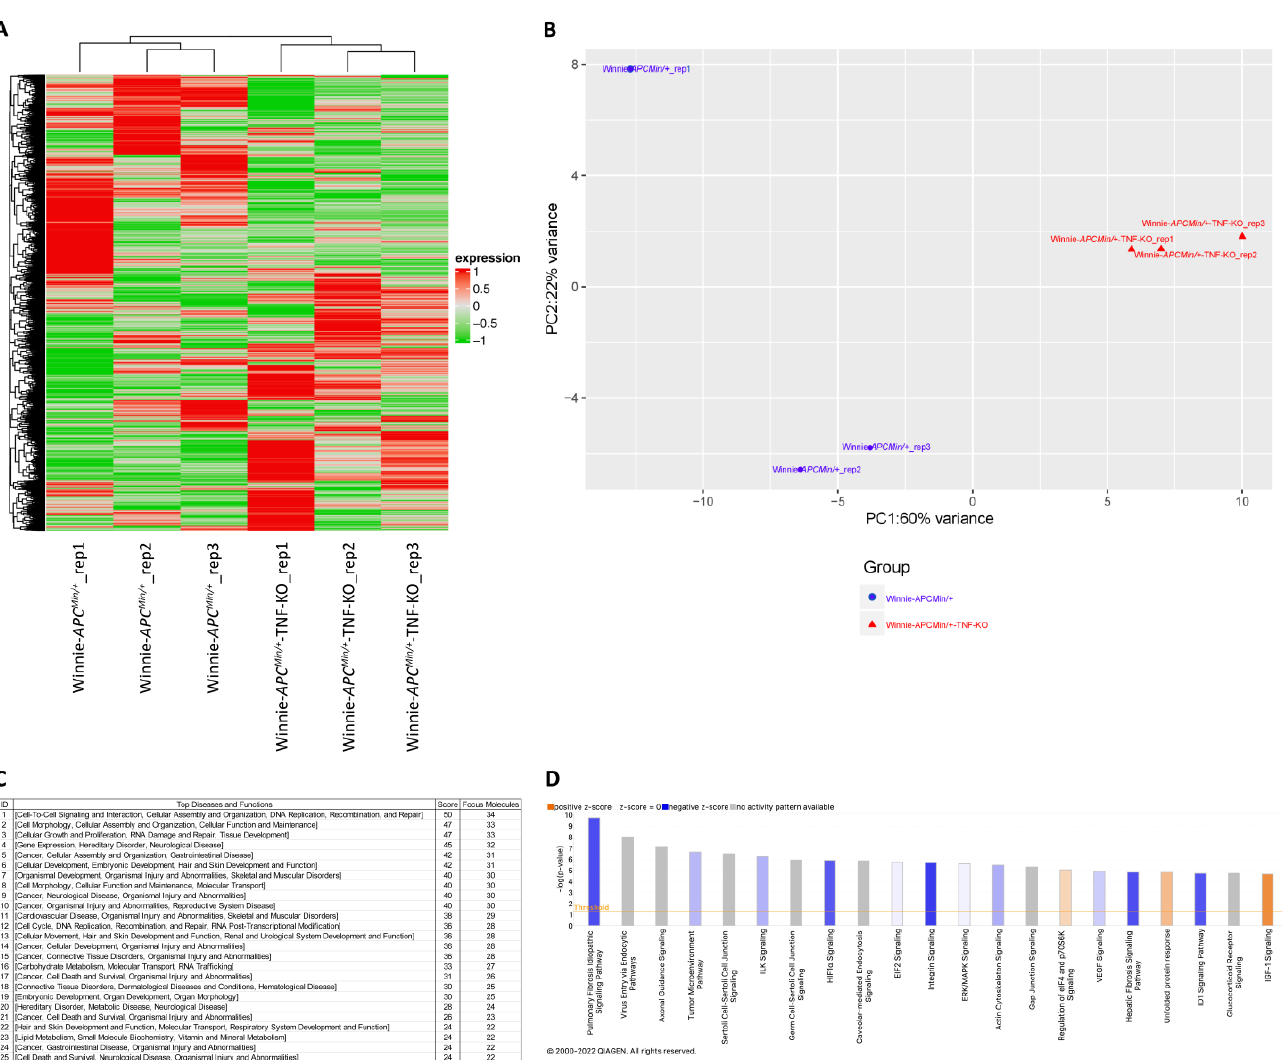
Figure 4. RNA sequencing analysis of macrodissected ACFs from Winnie- Apc Min/+ -TNF-KO and Winnie- Apc Min/+ distal colons . Two-dimensional hierarchical clustering ( A ) and PCA ( B ) analyses based on the significantly differentially modulated genes (FDR<0.05 and fold change threshold ≥1.5 and ≤−1 .5) discriminating Winnie- Apc Min/+ -TNF-KO and Winnie- Apc Min/+ ACFs . Top 25 diseases and functions ( C ) and 21 top canonical pathways ( D ) of the genes differentially expressed between the two groups were generated by the IPA. Where an activity pathway was available and a prediction z-score was associated to the canonical pathway, a color code was added to the bar graph (blue: positive; orange: negative). TNF: tumor necrosis factor; PCA: principal component analysis; IPA: ingenuity pathway analysis.